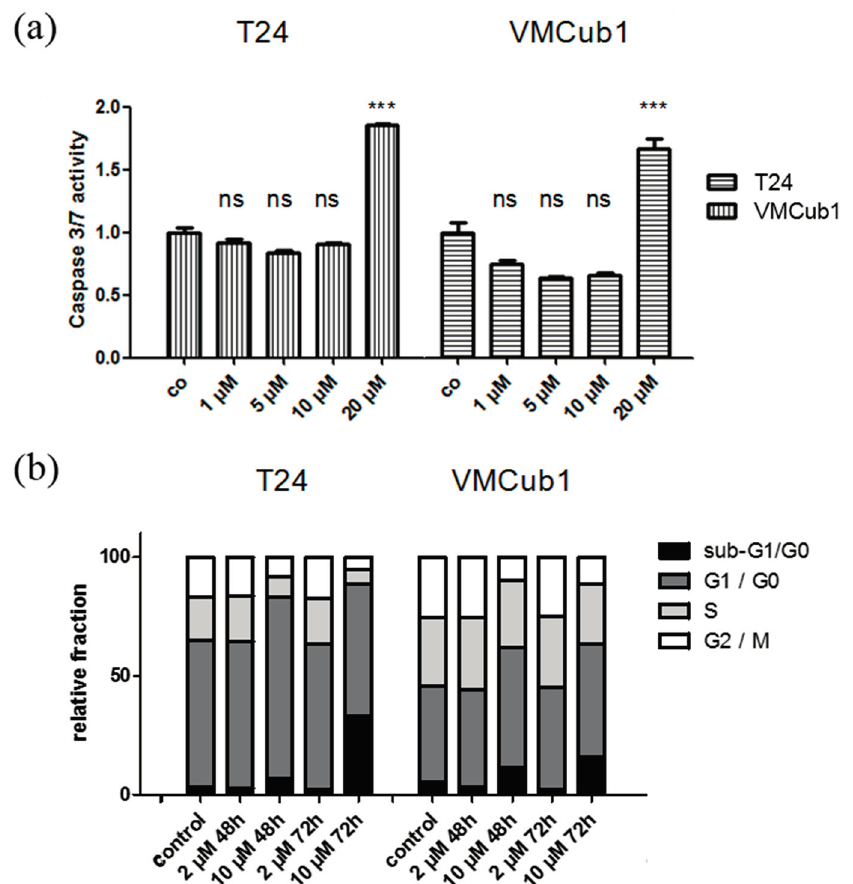
Figure 3. ( a ) Caspase 3/7 activity after sorafenib treatment with different concentrations for 24 h compared to untreated controls (co: control, set as 1). A significant increase in caspase 3/7 activity was noted in both T24 and VMCub1 cells at a concentration of 20 µM. (Bonferroni’s posttest, *** p < 0.001, ns: not significant); and ( b ) Changes in cell cycle distribution and amount of apoptotic cells (as sub-G1 fraction) after sorafenib treatment (2 and 10 µM, 48 and 72